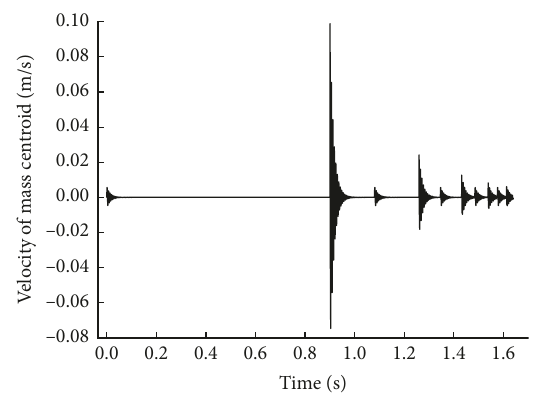
Figure 20: Centroid velocity of the metal